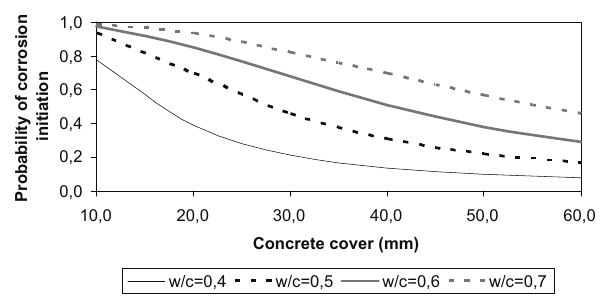
Figure 11 – Evolution for probability of corrosion initiation – C.A.III structural life-time = 15 years